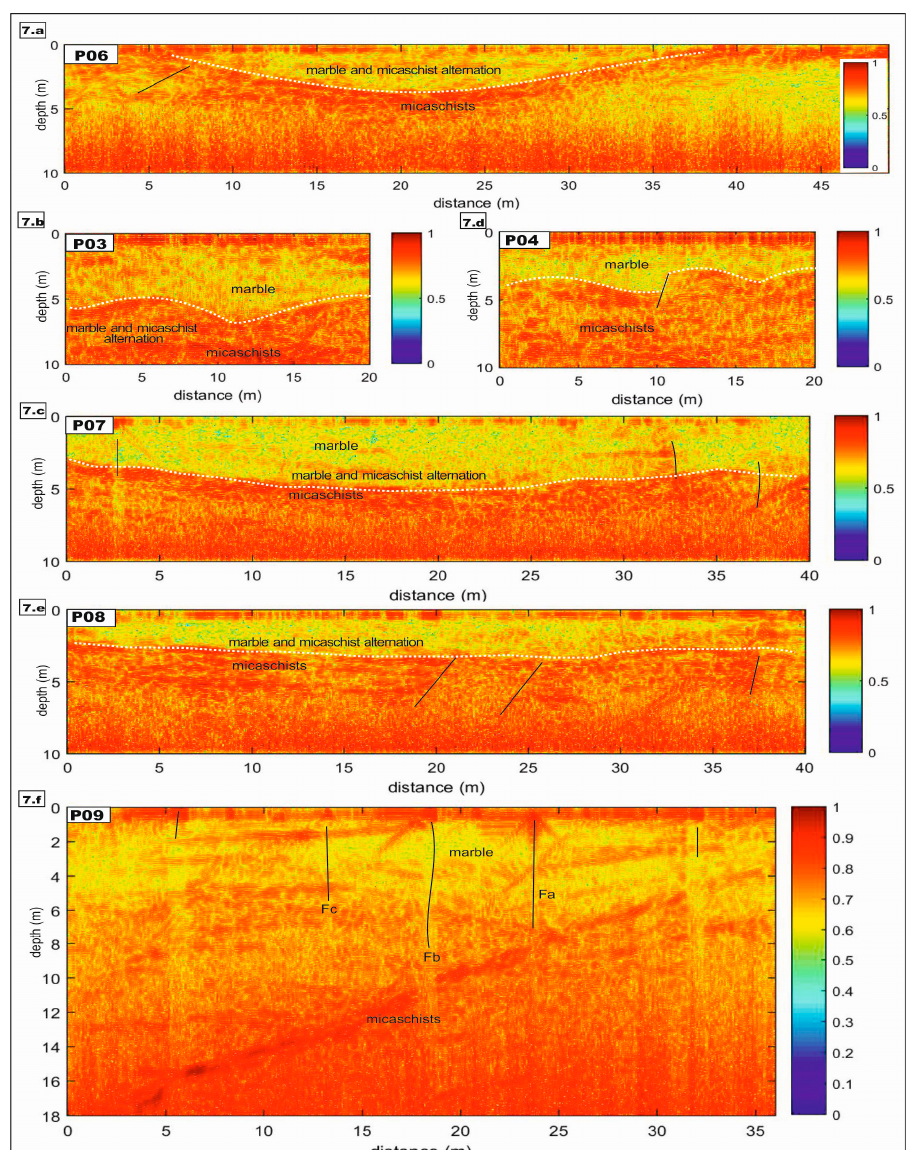
Figure 7. Pre-processed radargrams collected along different faces of the quarry (see Figure 4a). The intersection between the different profiles and the fractures is outlined (Figure 4). P06 ( a ); P03 ( b